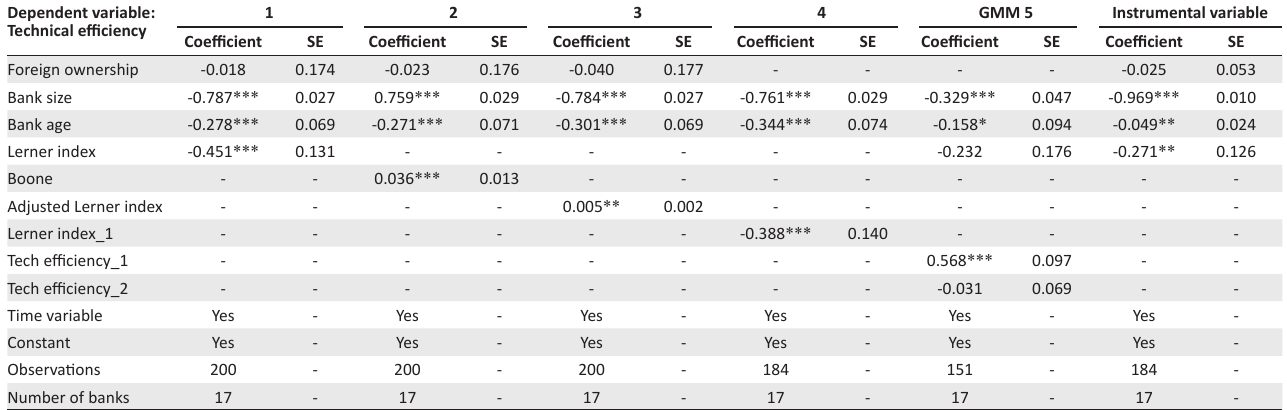
TABLE 6: Efficiency results. Dependent variable: Technical